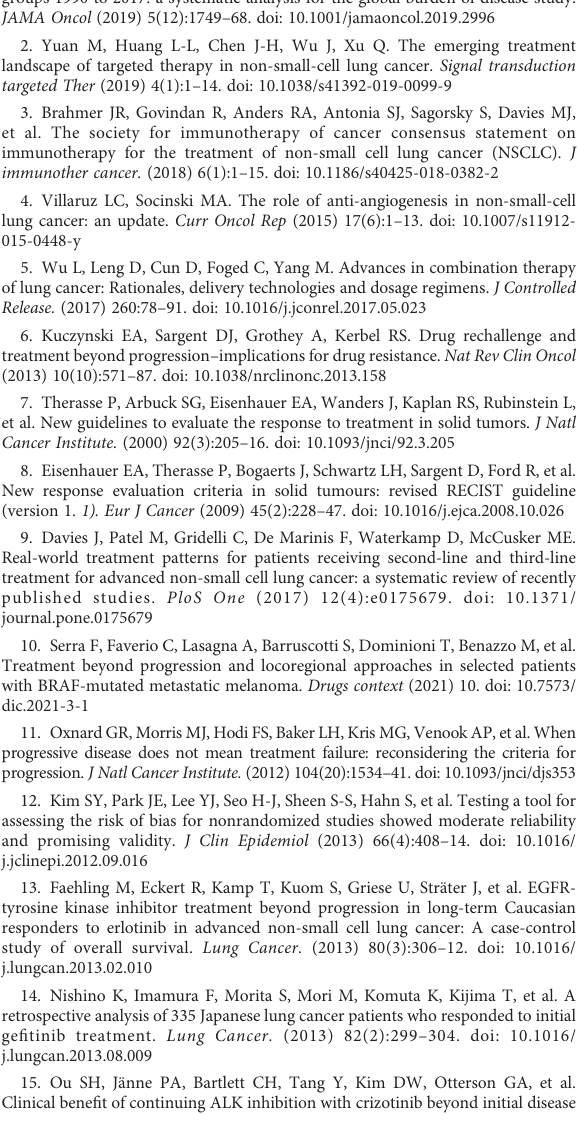
SUPPLEMENTARY FIGURE 3 Forest plot of subgroup analysis of association between overall survival from initiation of drugs and (A) classi fi cation of treatment beyond progression (TBP) drugs. (B) whether add-on therapy was allowed in the TBP group. (C)